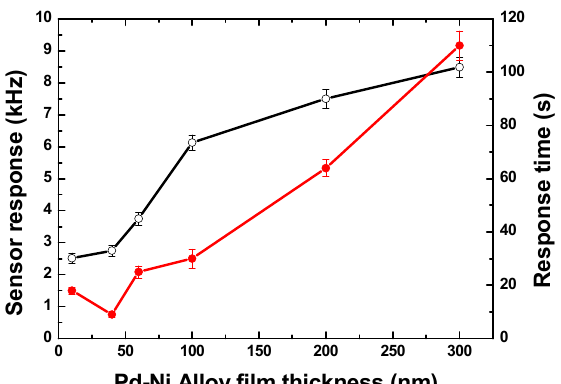
Figure 5. The measured sensor response towards 0.1% hydrogen gas employing the sensing devices coated with different Pd-Ni alloy thin-film thicknesses: ( a ) 10 nm; ( b ) 40 nm; ( c ) 60 nm; ( d ) 300 nm.